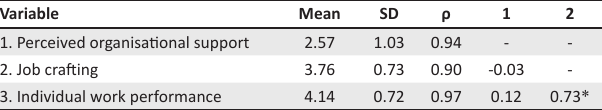
TABLE 2: Descriptive statistics, reliability coefficients and correlations ( n =